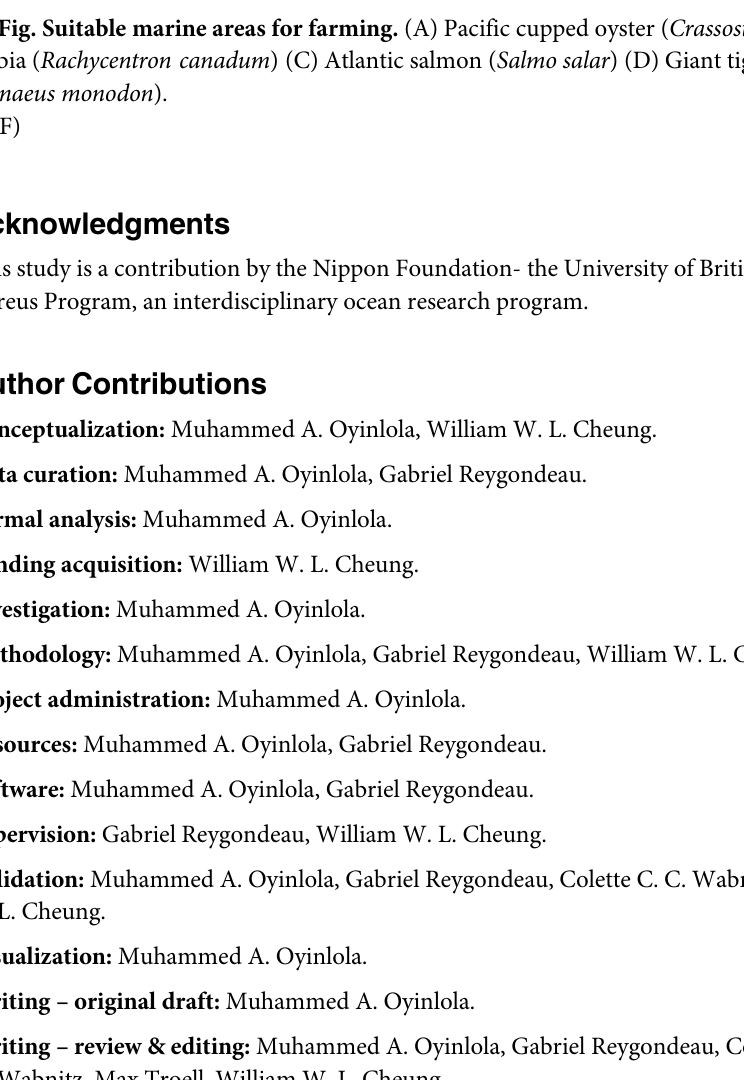
S3 Fig. The linear regression between predicted mariculture location and natural occur- rence habitat suitability. (A) Pacific cupped oyster ( Crassostrea gigas ) y = 0.01773x + 0.7906, R 2 = 0.8607, p < 0.0001. (B) Cobia ( Rachycentron canadum ) y = 0.04762x + 0.5525, R 2 = 0.5951, p < 0.0001. (C) Atlantic salmon ( Salmo salar ) y = 0.03001x + 0.7027, R 2 = 0.8118, p < 0.0001. (D) Giant tiger shrimp ( Penaeus monodon ) y = 0.02476x + 0.7012, R 2 = 0.7383, p < 0.0001. (TIF) S4 Fig. Latitudinal predicted species richness. (A) global mariculture species richness (B) Finfish (C) Crustacean (D) Molluscs (TIF) S5 Fig. Suitable marine areas for farming. (A) Pacific cupped oyster ( Crassostrea gigas ) (B) Cobia ( Rachycentron canadum ) (C) Atlantic salmon ( Salmo salar ) (D) Giant tiger shrimp ( Penaeus monodon ).